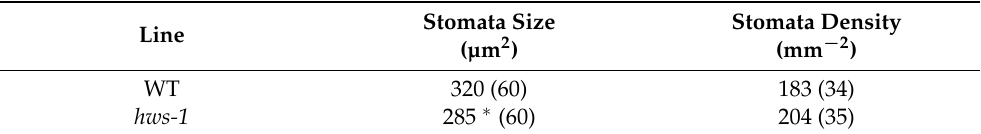
Table 1. Stomata are smaller in the hws-1 mutant. Stomata were counted from nail polish imprints from the third, fourth and sixth leaves using the ImageJ software [17,18]. Values represent means with standard deviations given in brackets ( n = 90 and n = 22 for size and density measurements, resp.). Star ( ∗ ) indicates significant difference at p < 0.01 in an unpaired t -test.